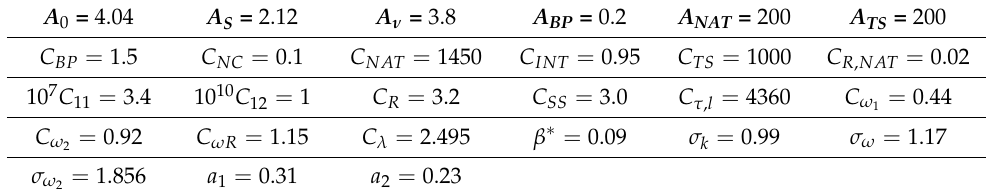
Table A1. The value of the parameters in the SPF k − v 2 − ω